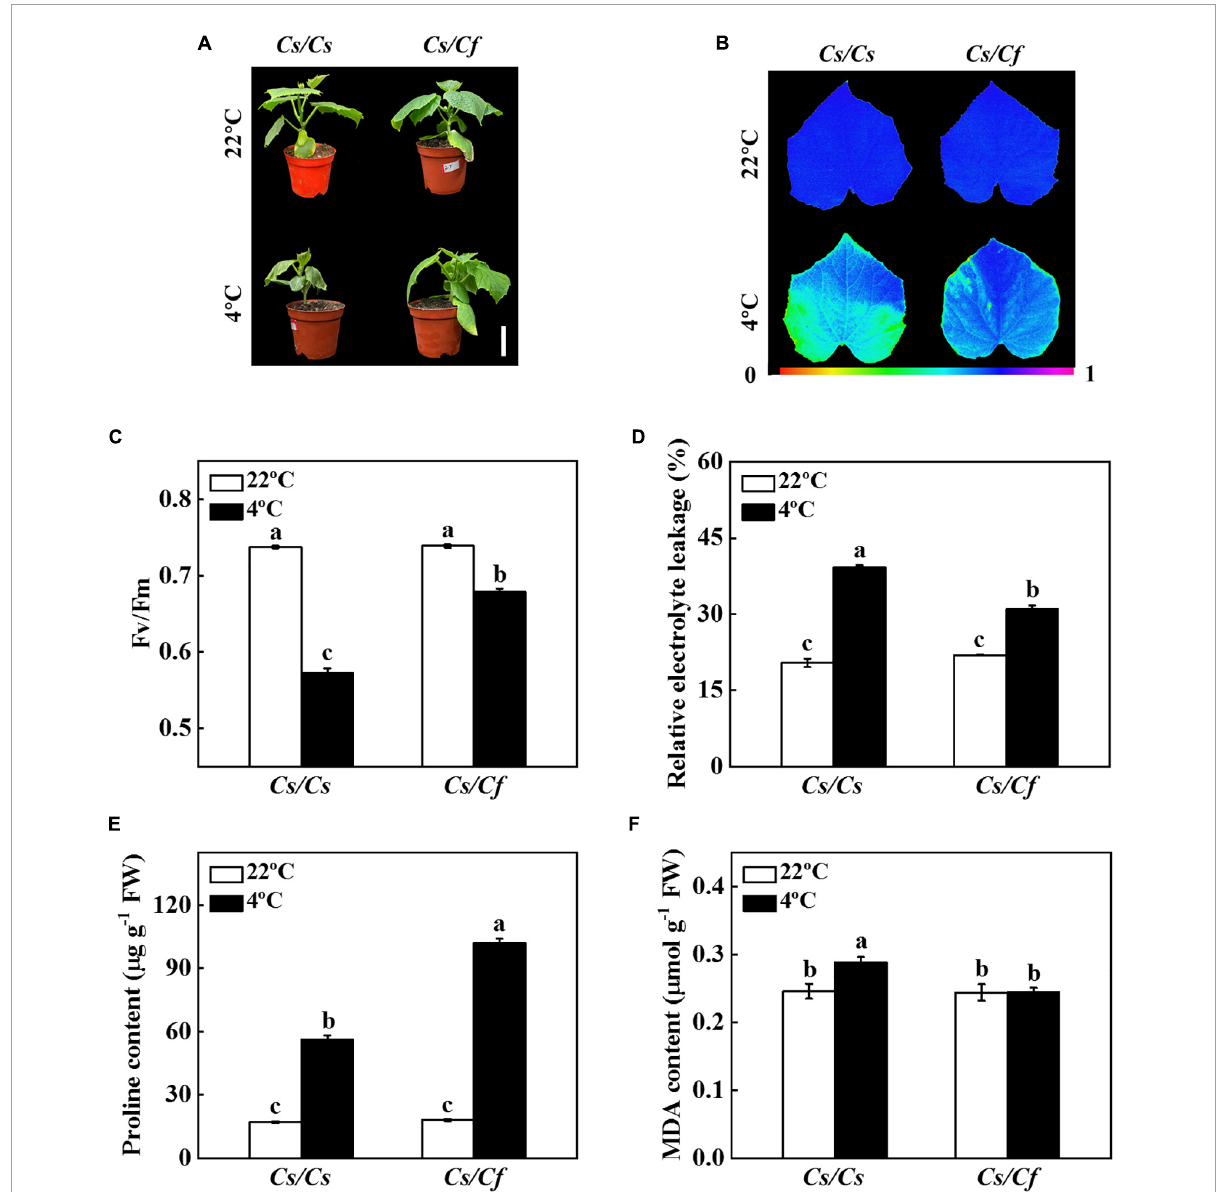
FIGURE1 Figleaf gourd rootstock increased cold tolerance of grafted cucumber seedlings. (A) Plant phenotype under cold stress for 7 d. Bar: 5 cm. (B,C) The maximum quantum yield of photosystem II (Fv/Fm). (D) Relative electrolyte leakage (REL). (E) Proline content. (F) Malondialdehyde (MDA) content in leaves. Cucumber seedlings grafted onto cucumber ( Cs/Cs ) and figleaf gourd ( Cs/Cf ) were treated with cold stress at 4 ◦ C for 7 d, and the phenotype, Fv/Fm, REL, and MDA content were measured. The results represent the mean ± SD of 3 replicates. Means with the same letter did not significantly differ at P < 0.05 according to Tukey’s test. FW, fresh